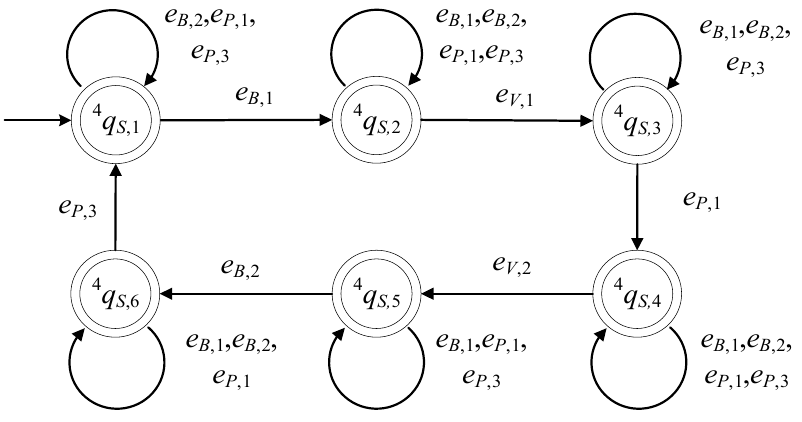
Figure 6. State diagram of 4 S .